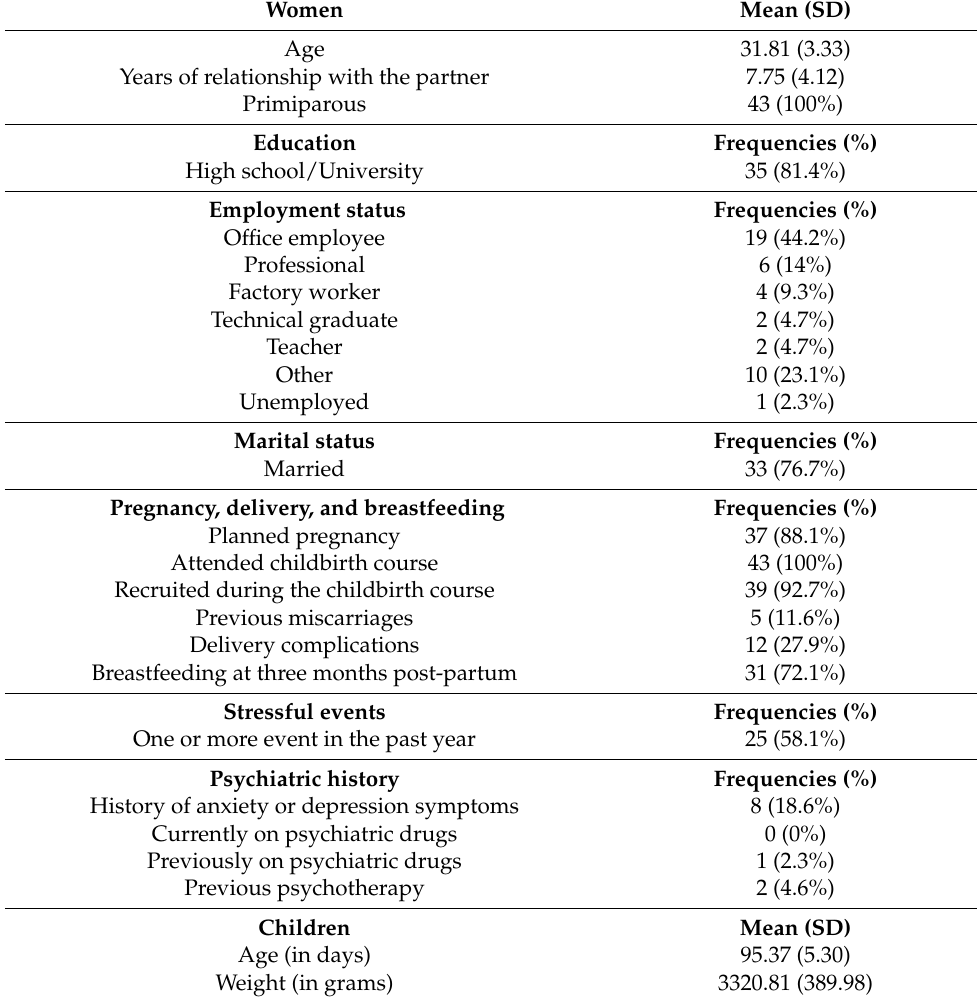
Table 1. Demographic, perinatal and psychosocial characteristics of the women and the children of the sample (N =